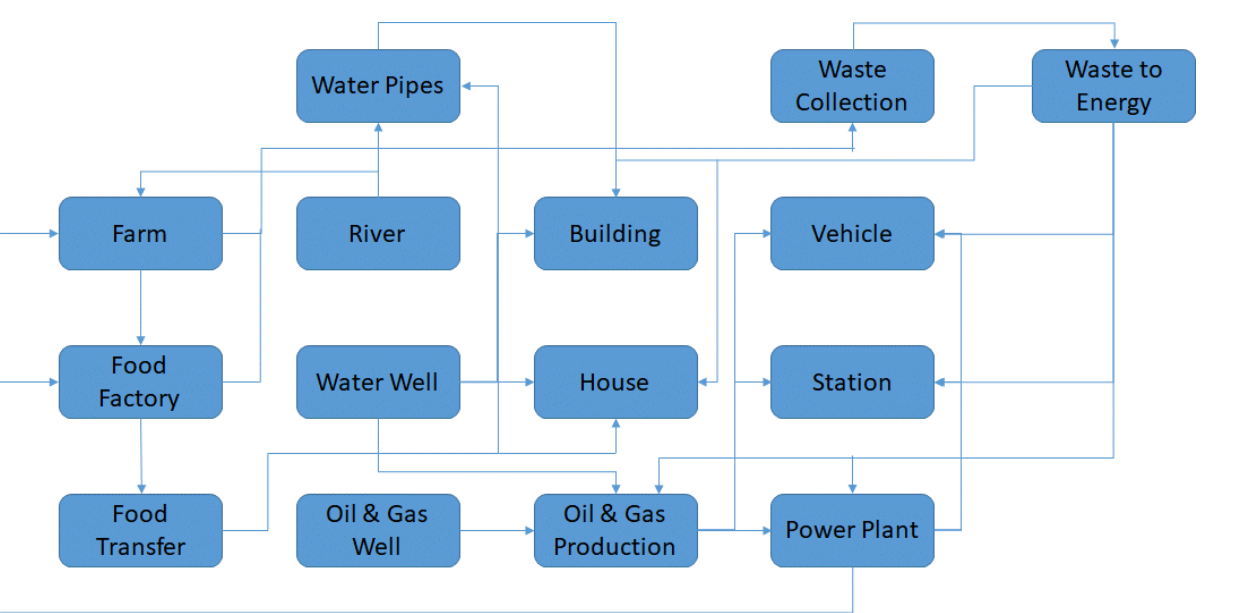
Figure 5. Possible interactions among different loads within interconnected infrastructures.